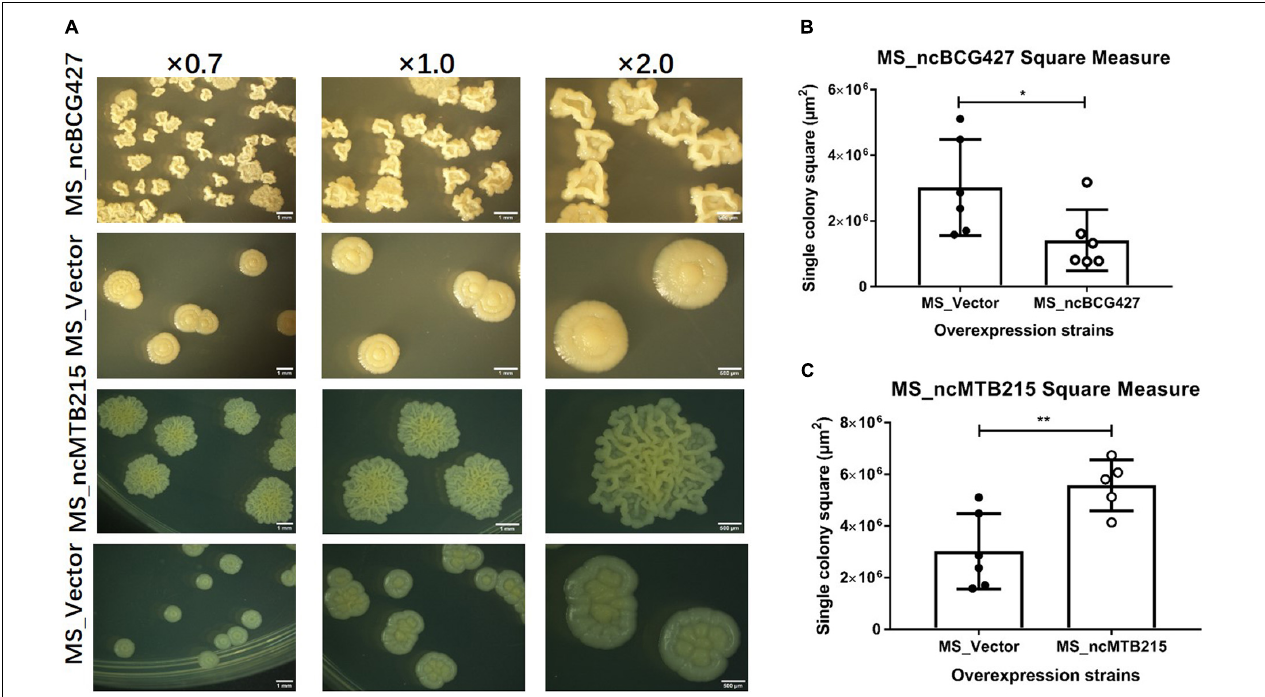
FIGURE 11 | Single-colony morphology and square measure of overexpressing Mycobacterium smegmatis MC 2 155: MS_ncBCG427 and MS_ncMTB215. (A) Single-colony morphology of different strains. (B) Square of MS_ncBCG427. (C) Square of MS_ncMTB215. * p < 0.05; ** p < 0.01 ( t